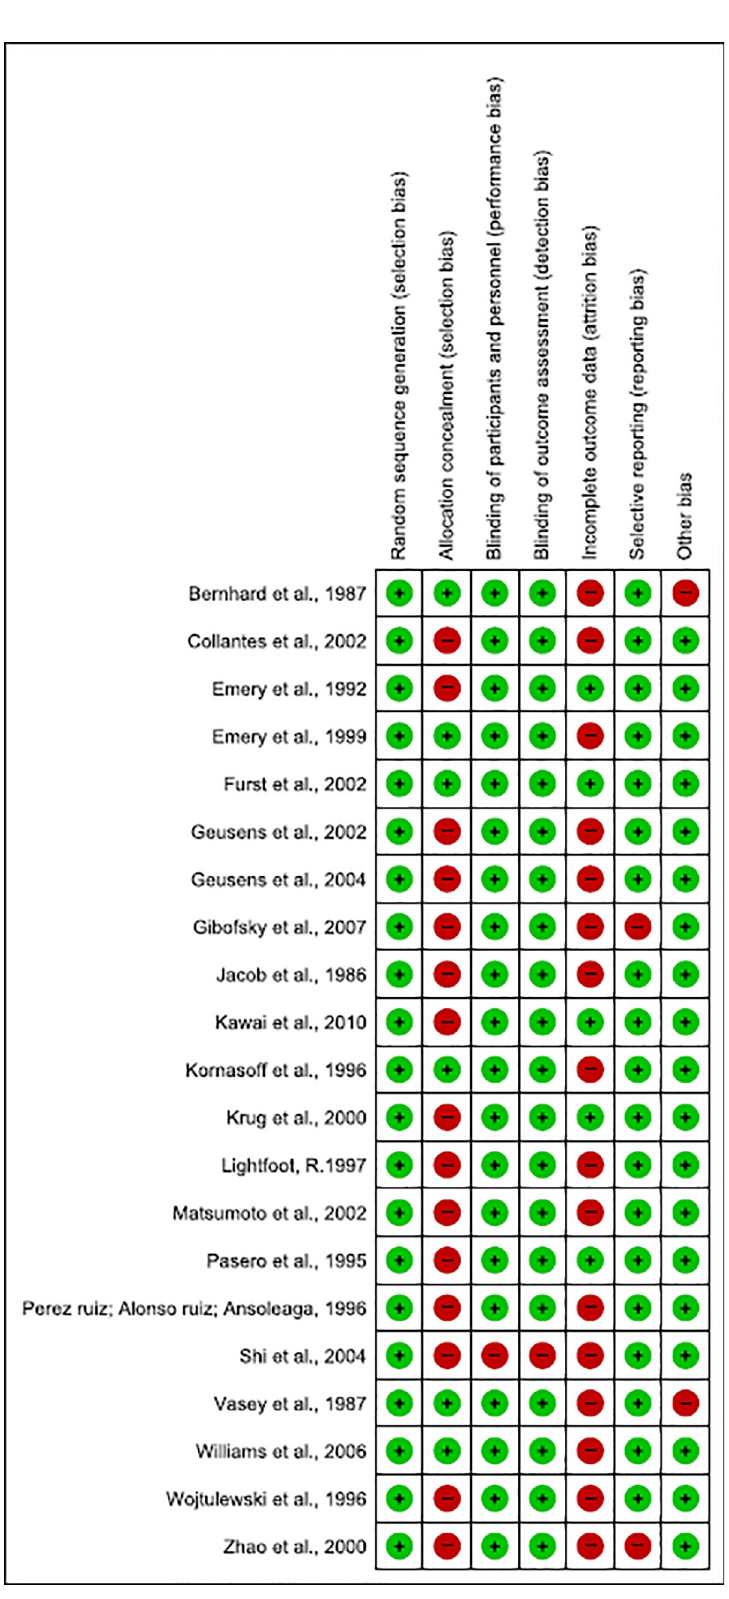
Fig 2. Risk of bias for studies on non-steroidal anti-inflammatories (n = 21).